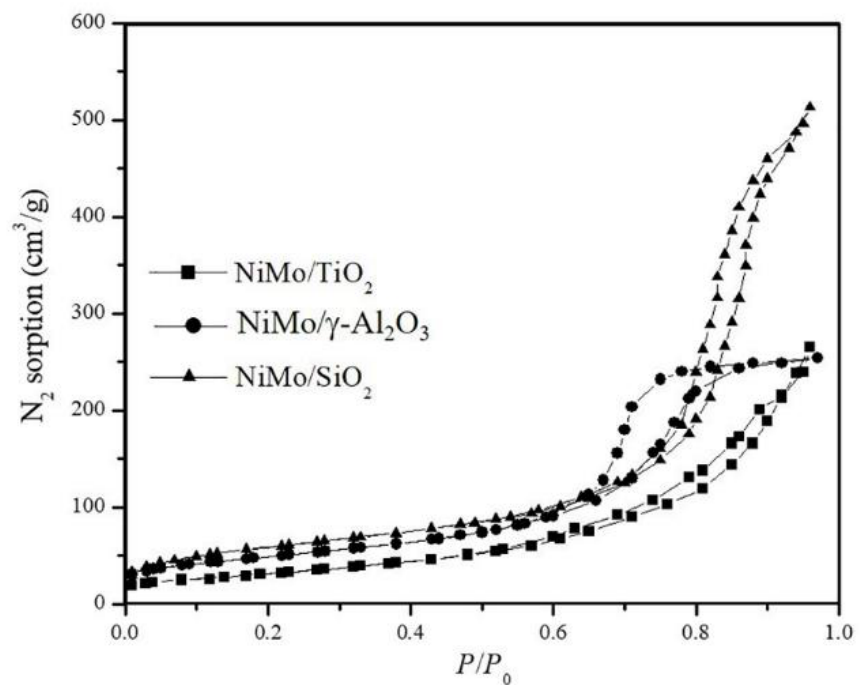
Figure 1. The adsorption – desorption isotherms of the calcined NiMo/γ -Al 2 O 3 , NiMo/SiO 2, and NiMo/TiO 2 catalysts.